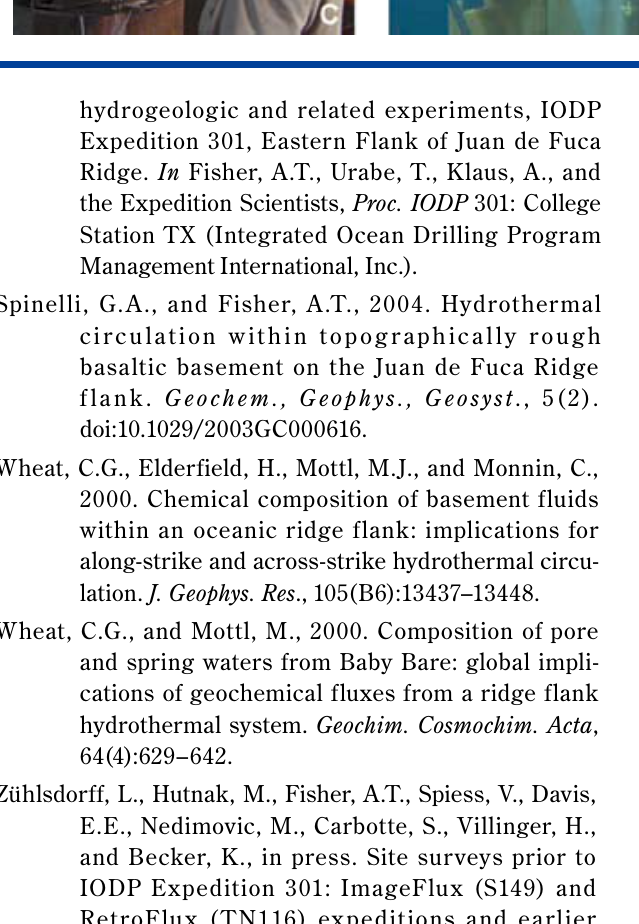
Figure 3. Photos of CORK operations during and after IODP Expedition 301. (A) CORK body being hoisted across the pipe racker to the rig floor. The pressure monitoring and sampling bay is visible; each CORK head has three bays, one each for pressure, fluid chemistry, and microbiology. (B) Below the rig floor, many hours of preparation are required to run hundreds of meters of packer inflation, monitoring, and sampling lines along side the 4-1/2" CORK casing. In this image, the tubing is broken out of the umbilical and is being run through the main CORK seal near the base of the CORK body. (C) OsmoSamplers attached to the CORK head prior to deployment. (D) IODP Expedition 301 CORK systems were visited three weeks after the end of drilling operations by ROV, to assess the state of the observatories, close valves left open during deployment to vent air, install pressure monitoring instrumentation (as shown), and collect short-term osmotic